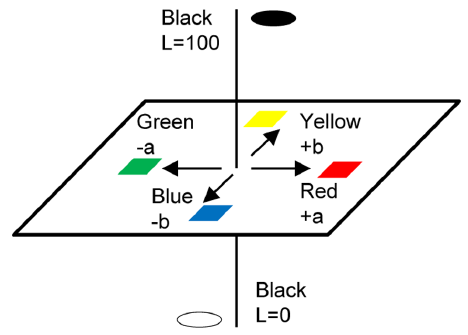
Figure 2. CIE Lab color space.